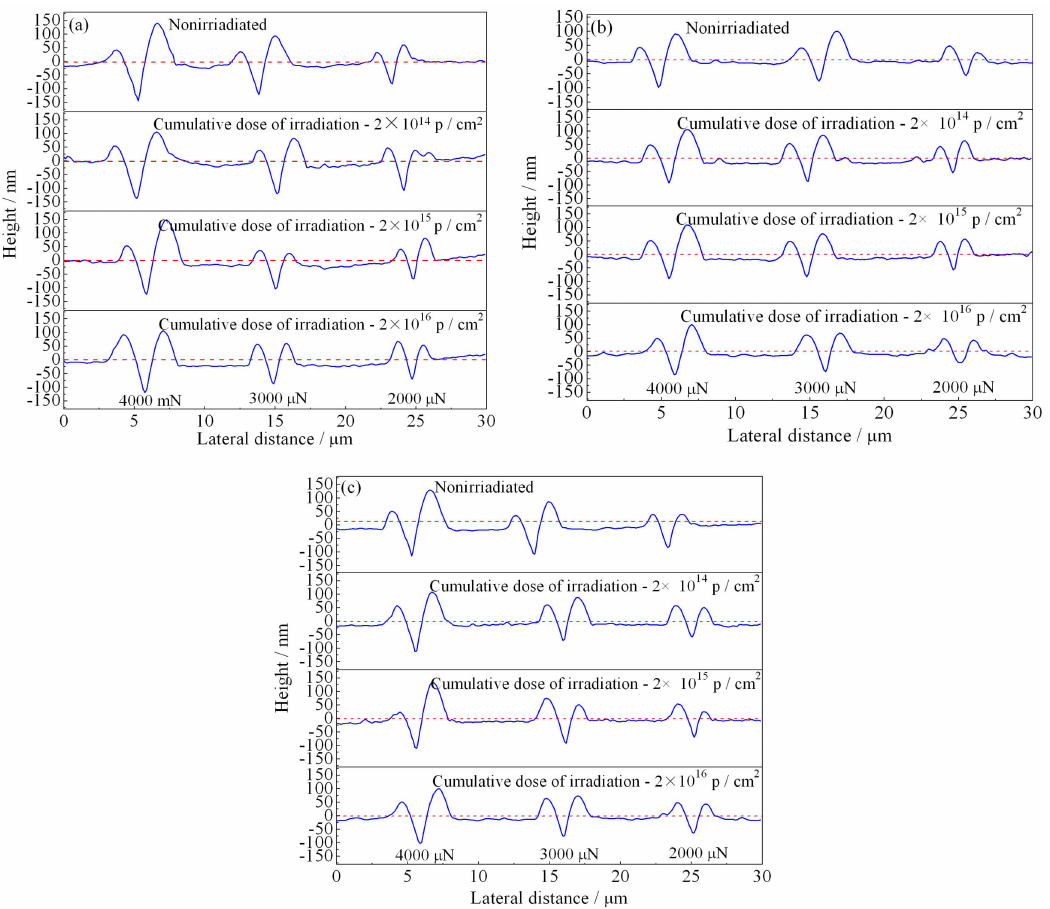
Figure 10. Wear profile of heat-treated AISI 420 steel after proton radiation with di ff erent cumulative charges. ( a ) Annealing state; ( b ) 600 ◦ C; ( c ) 700 ◦